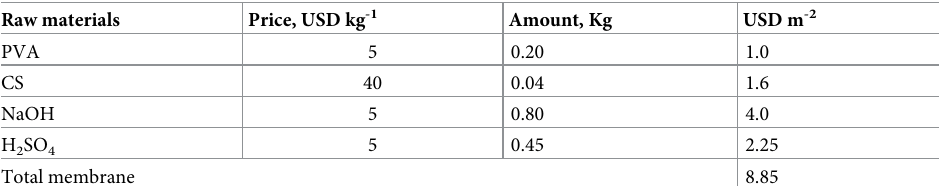
Table 4. Cost of the reagents needed to make 1 m 2 of PVA:CS